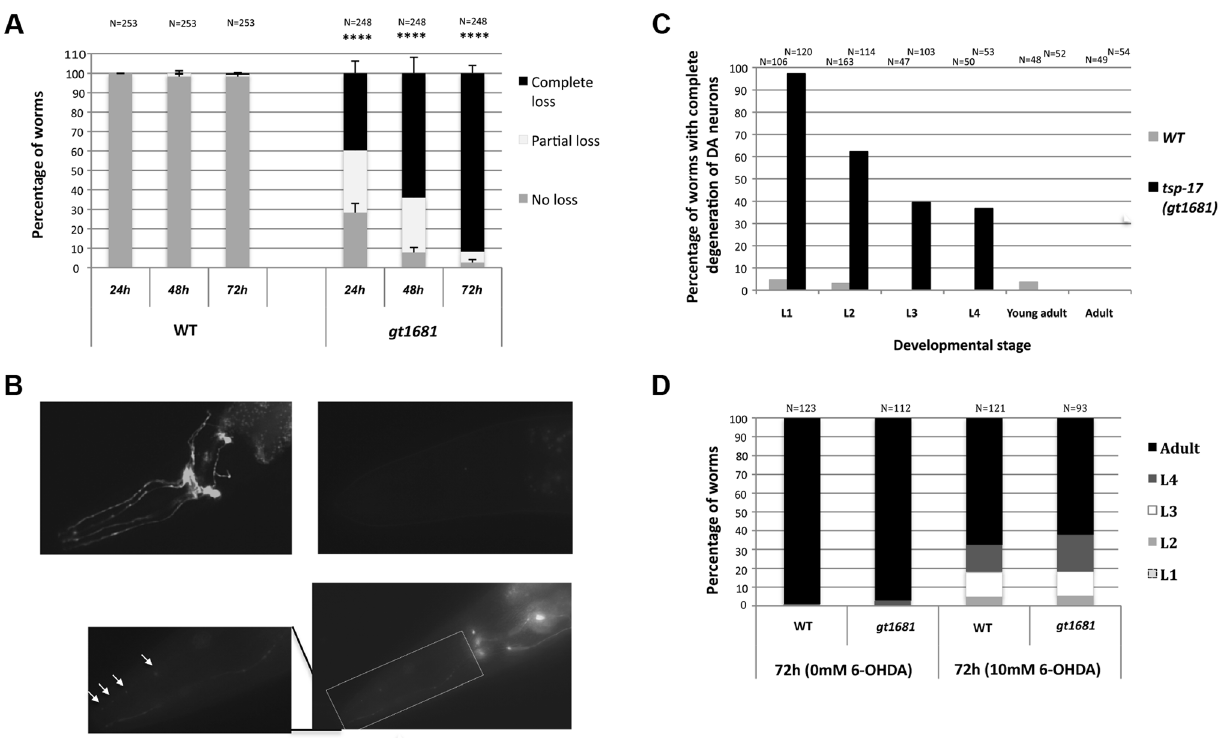
Figure 1. gt1681 mutants are hypersensitive to 6-OHDA. A . The extent of dopaminergic degeneration is indicated for wild-type and gt1681 mutant worms after intoxication with 10 mM 6-OHDA. Neurodegeneration of L1 worms was scored after 24, 48 and 72 h as described in Materials and Methods, and categorized as ‘‘complete loss,’’ ‘‘partial loss’’ or ‘‘no loss’’ phenotypes (labeled black, white and gray, respectively). Asterisks represent statistical significance of differences from wild-type (****p , 0.00001). B . Representative images showing progressive stages of dopaminergic neurodegeneration. Absence of degeneration in wild-type (upper left panel) and complete degeneration in gt1681 mutant worms 72 h post 6-OHDA intoxication (upper right panel, complete degeneration); lower panel and inset are examples of partial degeneration in gt1881 . Arrows indicate ‘blebs in degenerating neurons. C . Extent of neurodegeneration at various developmental stages in wild-type and gt1681 mutant worms 72 h post 6-OHDA intoxication. D . In wild-type and gt1681 worms, development is equally retarded following treatment with 6-OHDA. Progression to various developmental stages was scored once 95% of untreated worms reached adulthood.